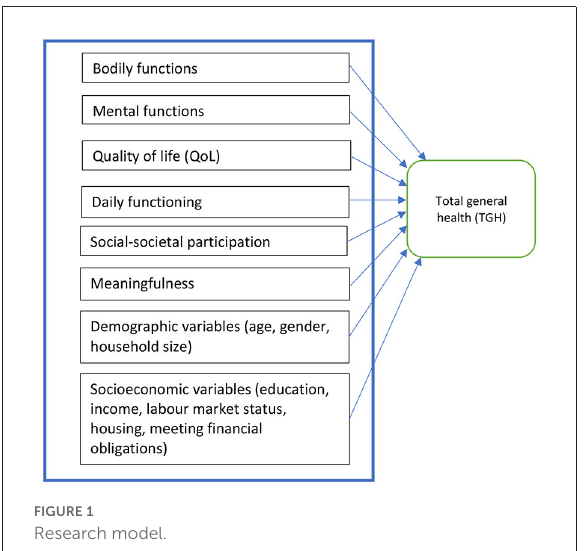
FIGURE1 Research